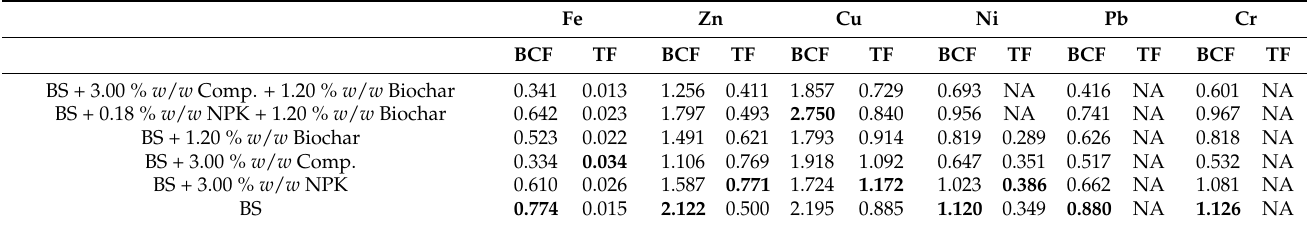
Table 6. Mean BCF and TF of Fe, Zn, Cu, Ni, Pb, and Cr; the highest values are marked in bold. Fe Zn Cu Ni Pb Cr BCF TF BCF TF BCF TF BCF TF BCF TF BCF